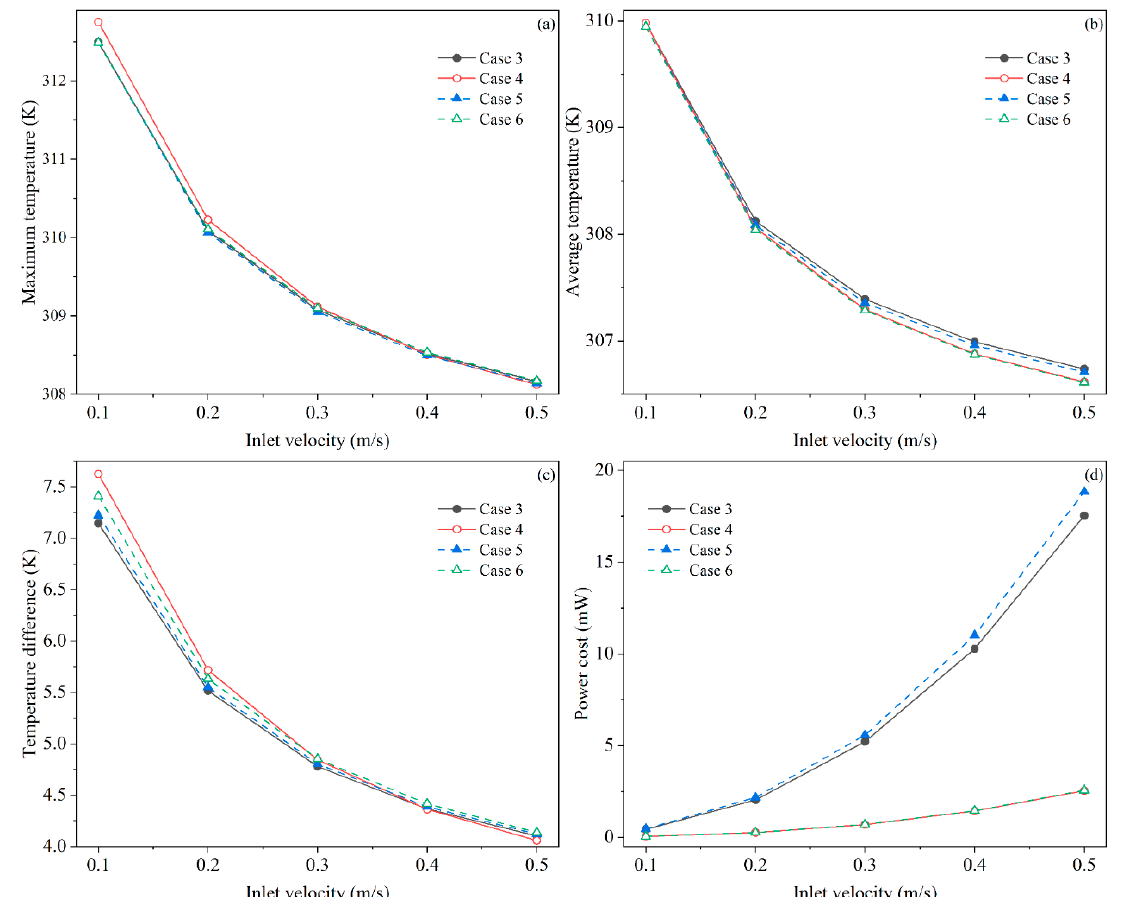
Figure 10. Thermal-hydraulic performance of Cases 3–6 with the variation of inlet flow velocity: ( a ) maximum battery temperature; ( b ) average battery temperature; ( c ) battery temperature difference, and ( d ) required power cost.